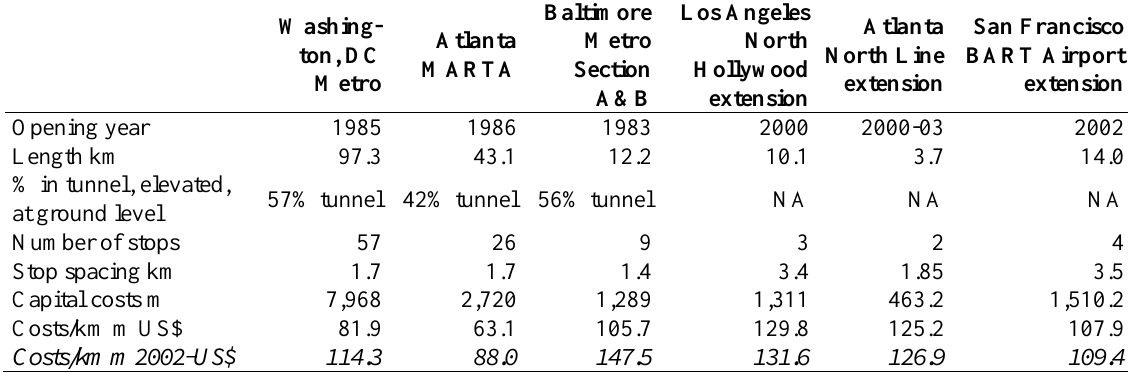
Table 2. Capital costs per route-kilometre for six metros in the USA.